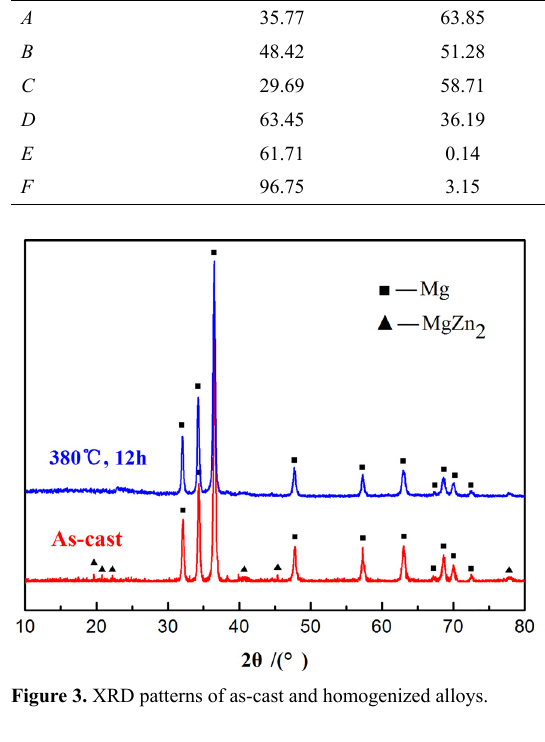
after homogenization. The first endothermic peak at 354.7